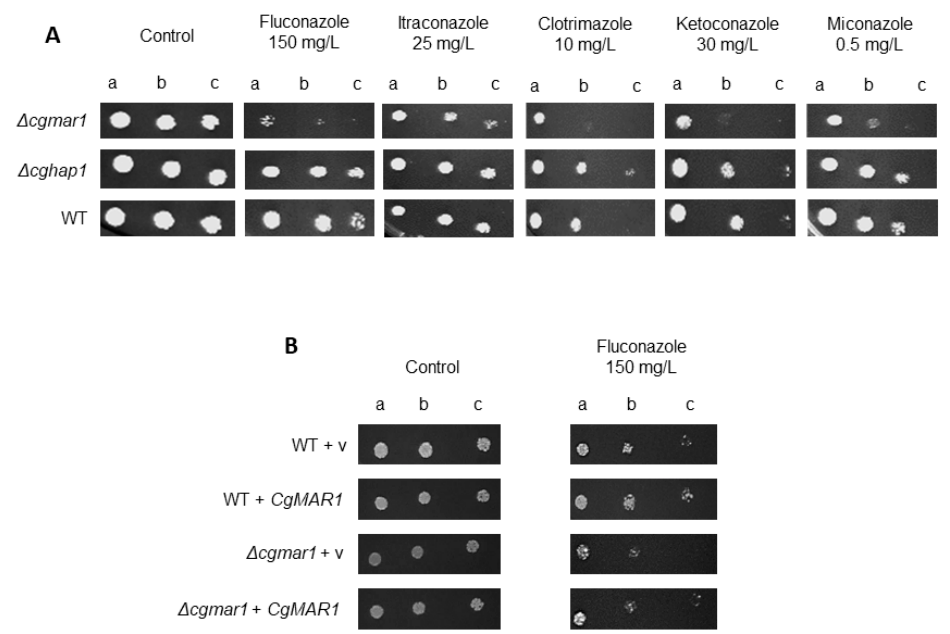
Figure 1. CgMAR1 (ORF CAGL0B03421g ) mediates tolerance to fluconazole and other azoles. ( A ) Comparison of spot growth assays of the KUE100 C . glabrata wild-type and derived KUE100_ ∆ cghap1 and KUE100_ ∆ cgmar1 deletion mutants in the presence of azole antifungals. ( B ) Comparison of spot growth assays of the KUE100::URA- C . glabrata wild-type and derived KUE100_ Δ cgmar1 ::URA- deletion mutant harboring the pGREG576 cloning vector or the pGREG576_PDC1_ CgMAR1 expression plasmid in the presence of fluconazole. The inocula were prepared as described in the Materials and Methods section. The cell suspensions used to prepare the spots were 1:5 (b) and 1:25 (c) dilutions of the cell suspensions used in (a). The images displayed are representative of at least three independent experiments. Table 2. Fluconazole susceptibility profiles determined by MIC values in deletion mutants for CgMAR1 and CgHAP1 and the corresponding parental strain (WT).